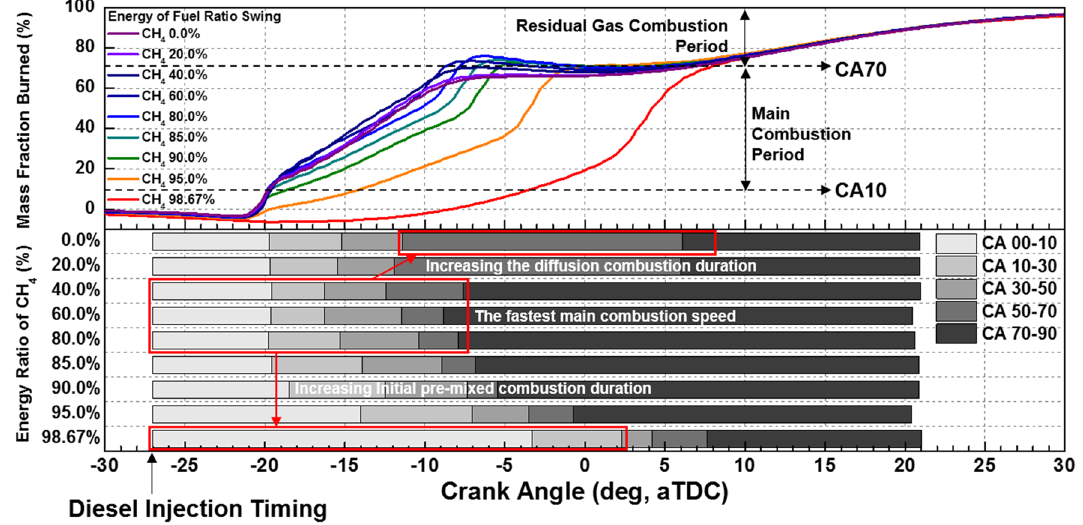
Figure 9. MFB with respect to the fuel mixture